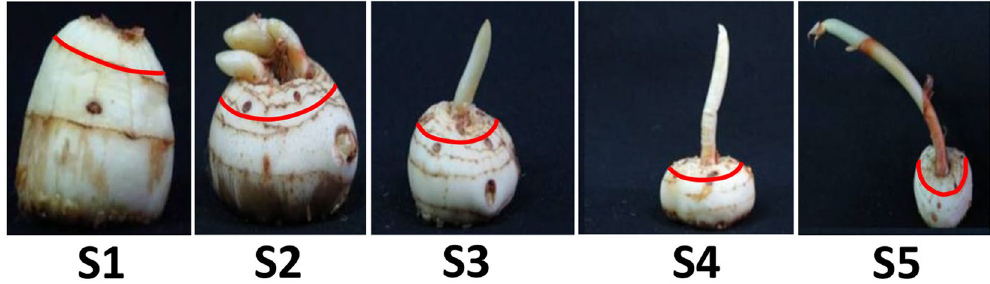
Figure 1. Dormancy and sprouting in Saffron corm ( C. sativus L.). Saffron corm at key developmental stages are shown: S1 represents the dormancy period (early May-July), S2 depicts the initiation and differentiation of leaf primordia (early July-August), S3 shows the initiation and differentiation of floral primordia (early August -late August), S4 denotes elongation of perianth tube (late August-early October), while S5 indicates bud break and floral anthesis (early October- late October). Red circle in each picture represents the apical bud portion from where tissue was taken for the present